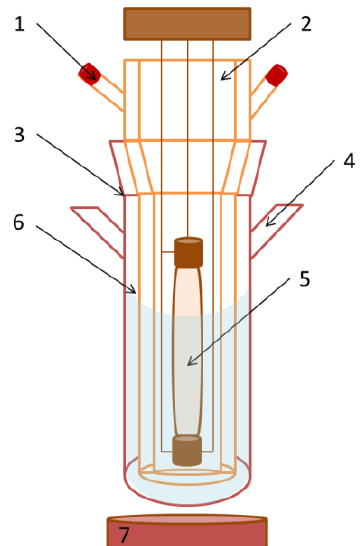
Figure 1. Reaction system: (1) lamp cooling system; (2) double-walled immersion well reactor; (3) photoreactor; (4) port for taking samples; (5) 125 W ultraviolet (UV) lamp; (6) mother solution; and (7) magnetic stirrer.